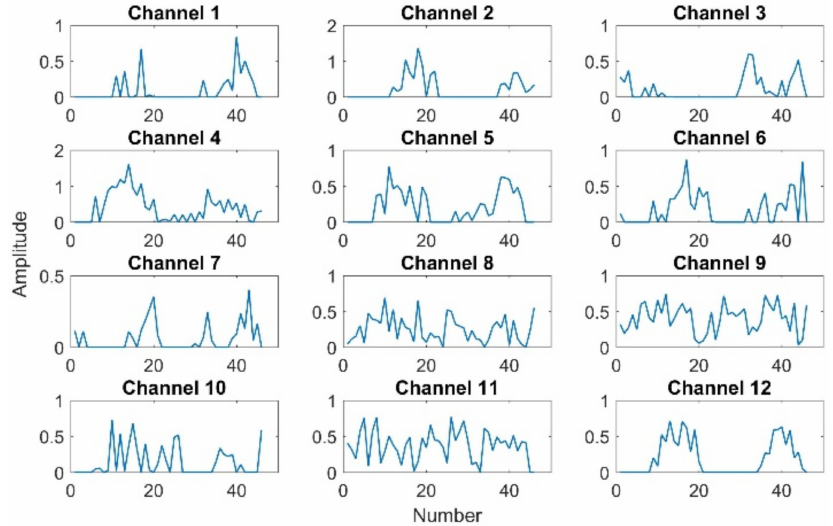
Figure 17. Output of the first convolutional layer.